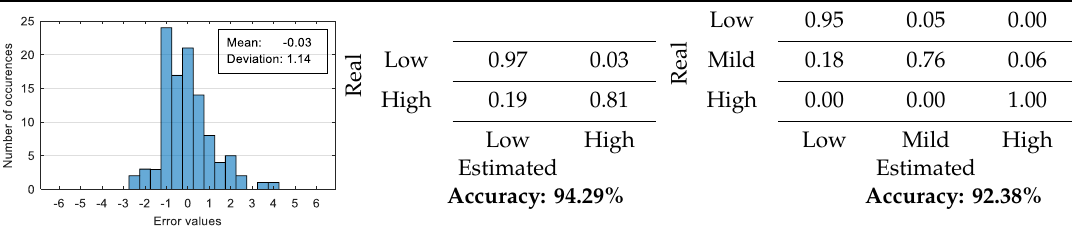
Sensors 2020 , 20 , x FOR PEER REVIEW Table 11. Distribution of estimation errors and confusion matrices for levels 2 and 3—using six features.